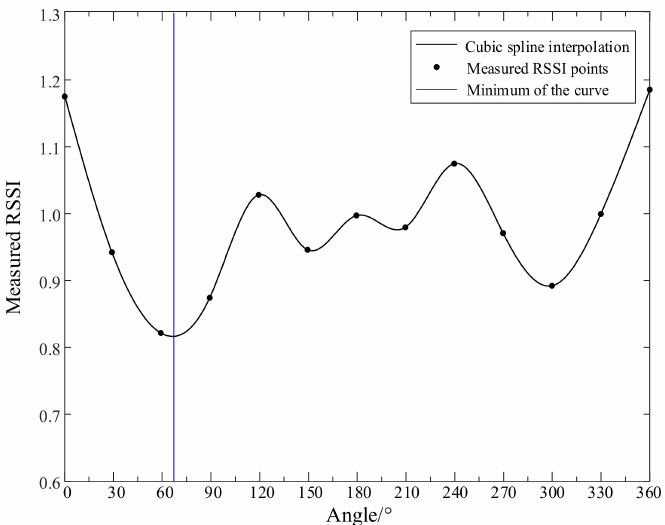
Figure 11. Diagram of cubic spline